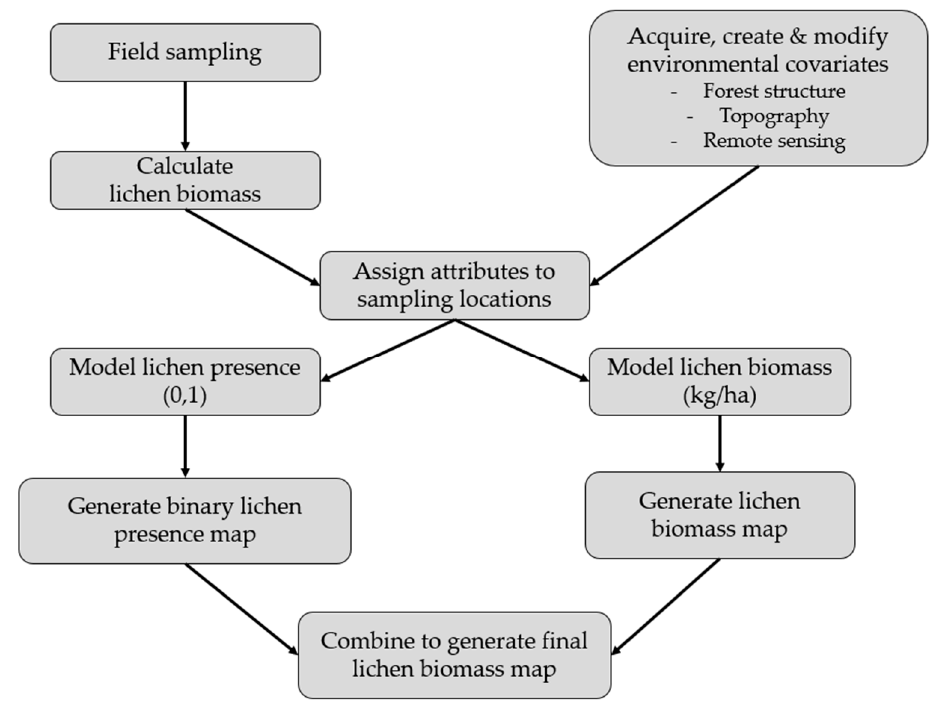
Figure 2. Framework used to generate a lichen biomass map for Woodland Caribou Provincial Park, Ontario, Canada.